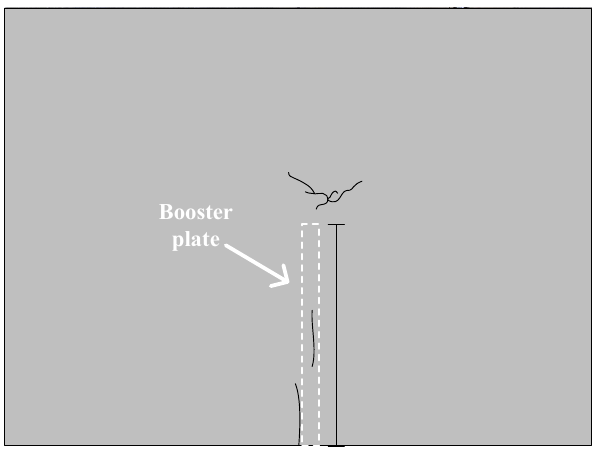
Figure 15. Schematic view of the crack distributions during the soil cracking stage.